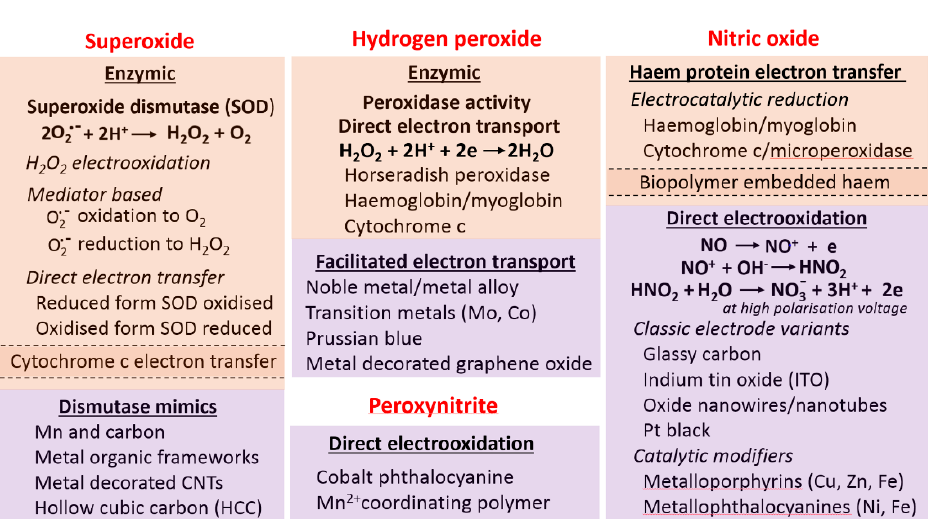
Figure 4. Summary of electrode chemistries and electrode surface modifications used for electrochemical RONS measurement. Associated barrier membranes and permselective layers are not included here but are an indispensable element of any practical device. The different shaded blocks identify the different generic approaches: biological, catalytic/inorganic. Few peroxyinitrite sensors have been attempted; selective barrier films are typically needed; an alternate, less specific anion affinity micro-architectured surface is not included here.